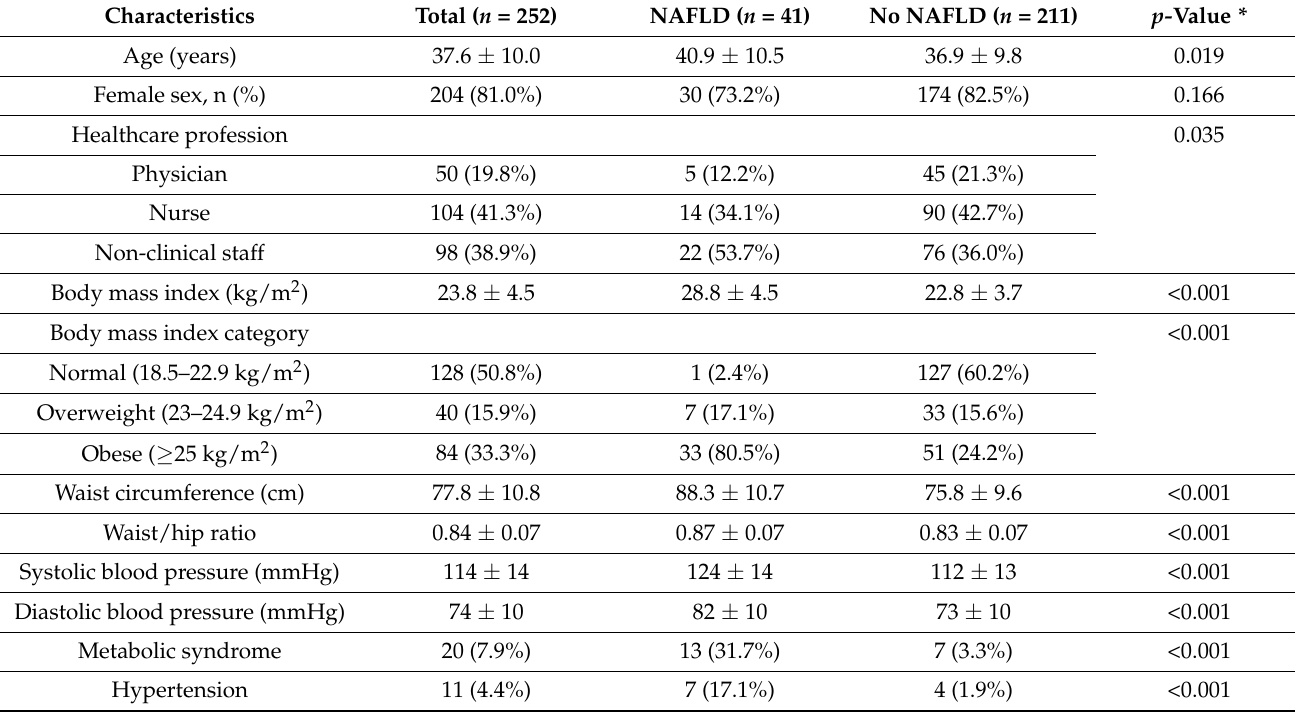
Table 1. Demographic, clinical, and laboratory characteristics of the study